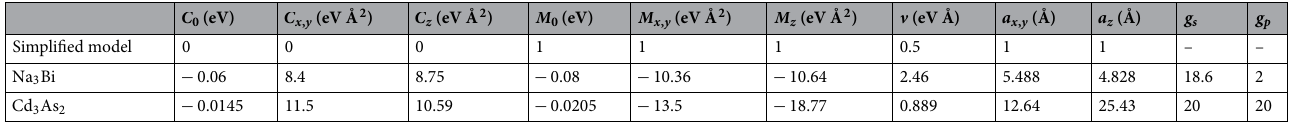
Table 1. Value of parameters of the simplified model, Na 3 Bi 15,36 and Cd 3 As 2 23,37